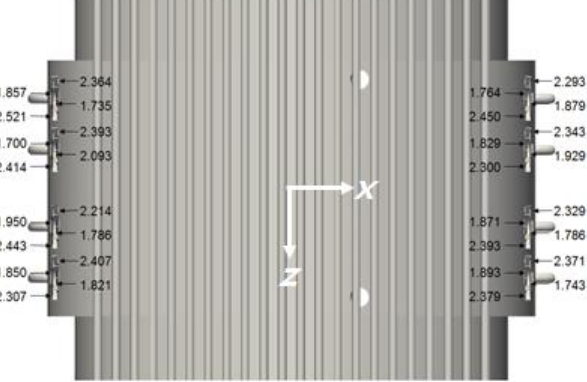
Figure 11. Mean velocities at the inlet nozzle, final time of the simulation (top view, unit: m/s).